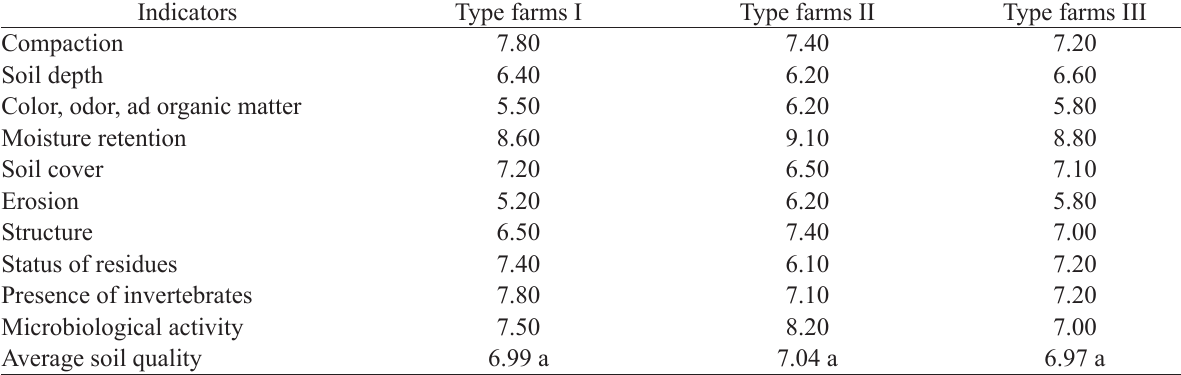
Table 2. Soil quality of “type farms” with cacao in Huicungo (San Martín) Indicators Compaction